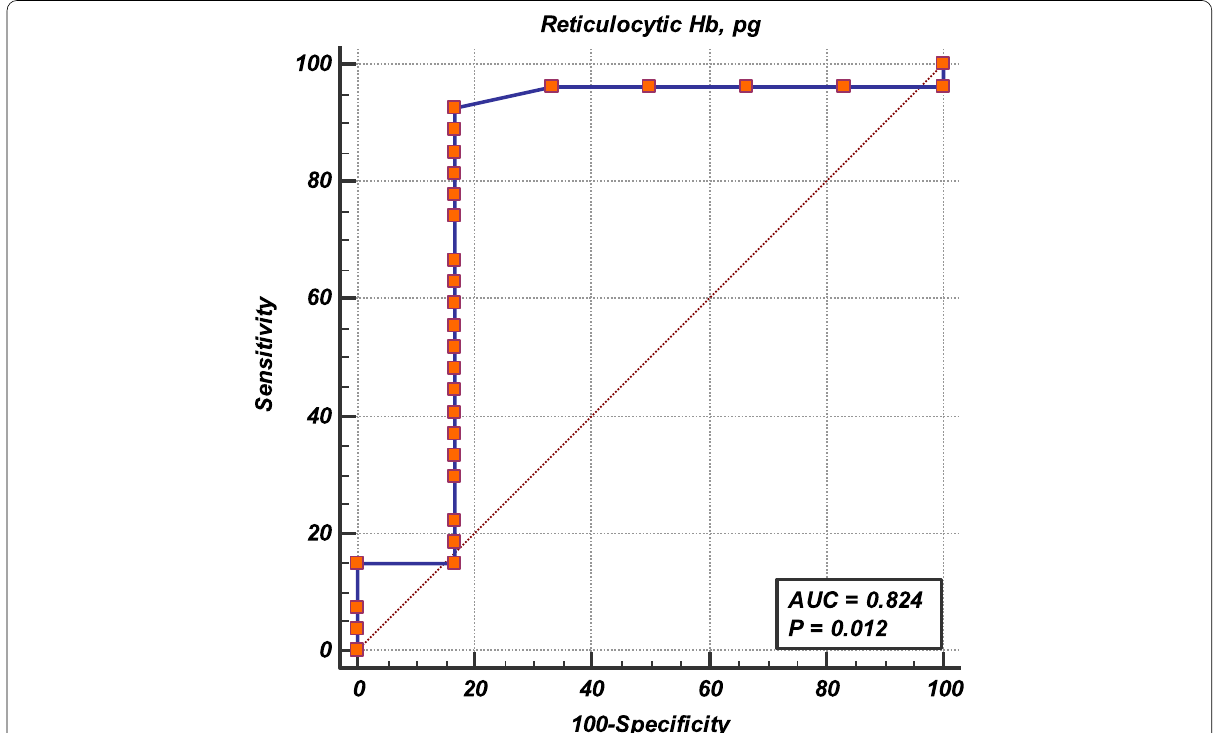
Fig. 1 The usefulness of Reticulocytic Hb with area under the ROC curve (AUC) as a diagnostic marker for iron deficiency anemia in patients with